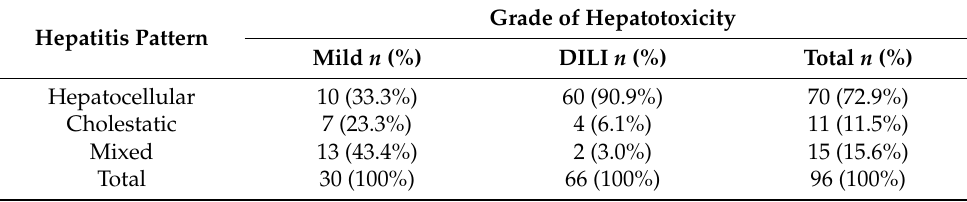
Table 1. Distribution of hepatitis pattern according to the grade of hepatotoxicity. Hepatitis